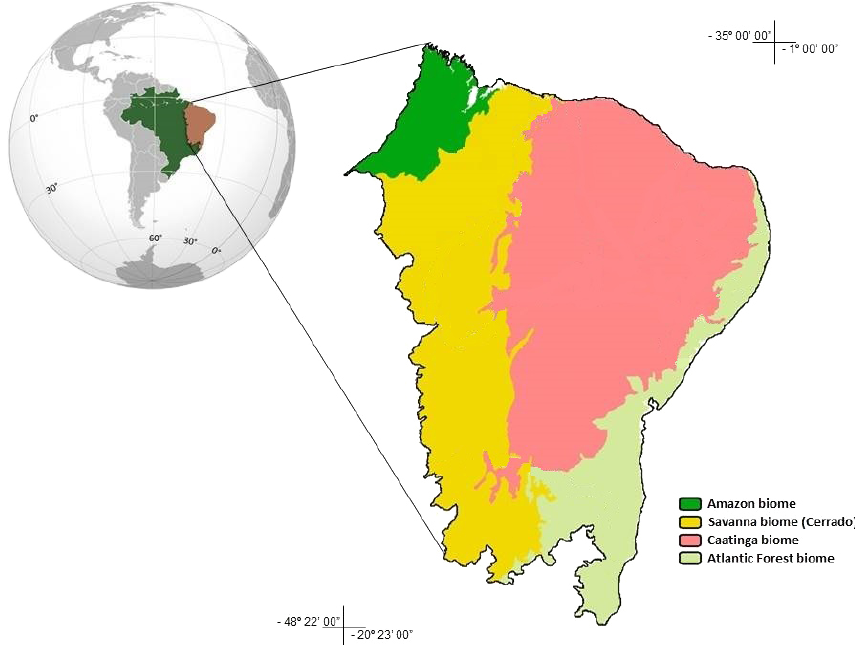
Figure 1. Study area location and its main